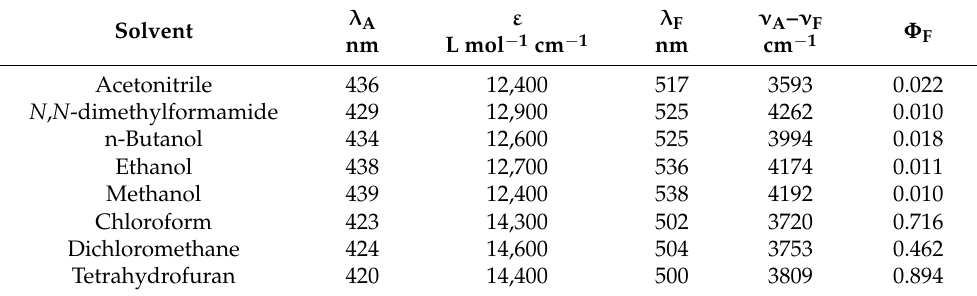
Table 1. Photophysical characteristics of compound NI1 in different organic solvents.